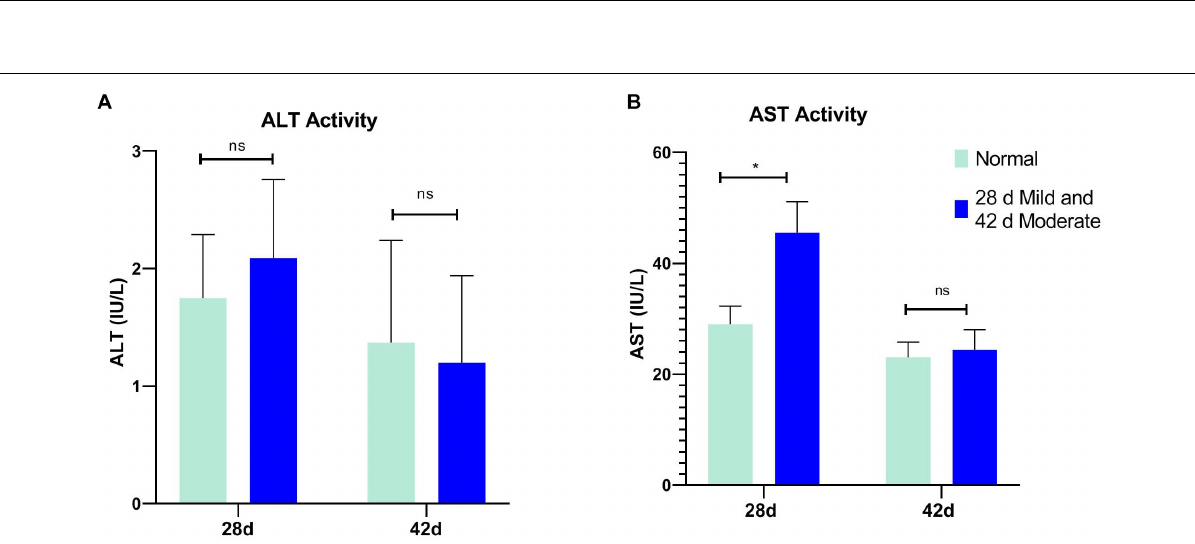
Frontiers in Physiology |